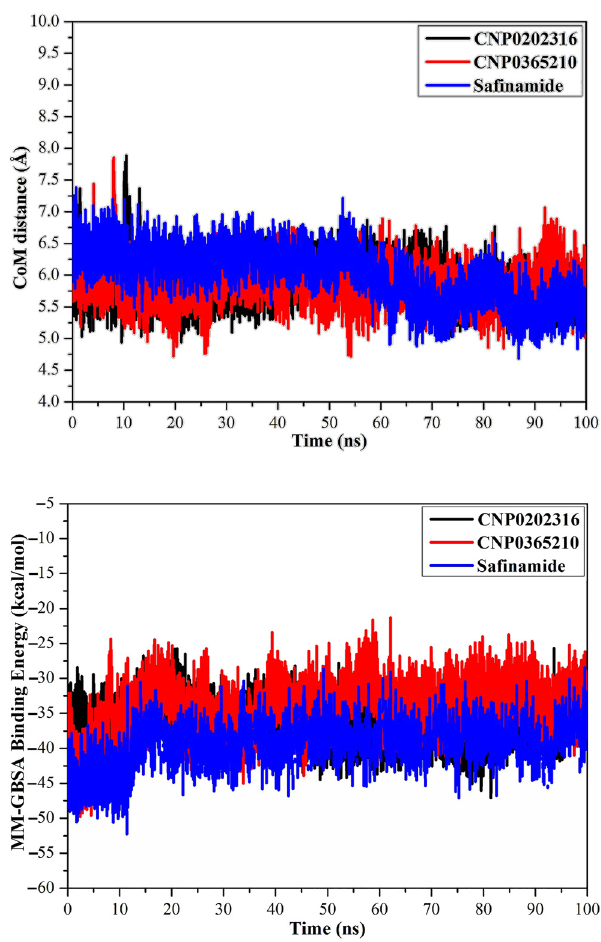
Figure 14: Estimated MM-GBSA binding energy per frame for CNP0202316 (in black), CNP0365210 (in red), and safinamide (in blue) with MAO-B over a 100 ns MD